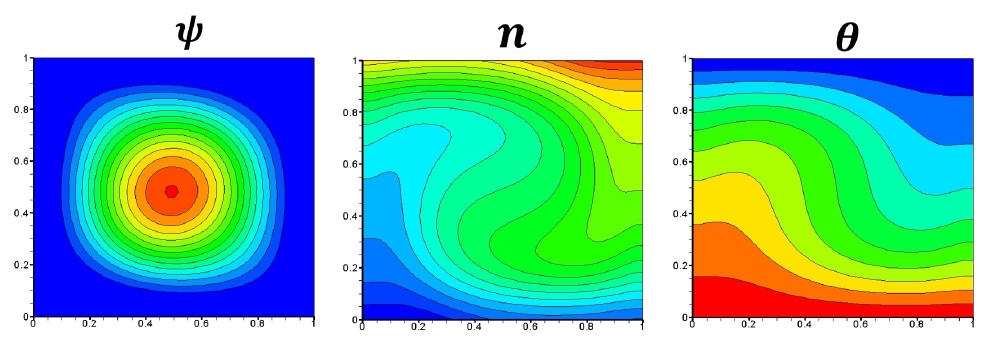
Figure 2. From left to right Ψ , n , θ . For Ra = 10 3 , Ra T = 4 × 10 3 and Sc = Pe = Le =